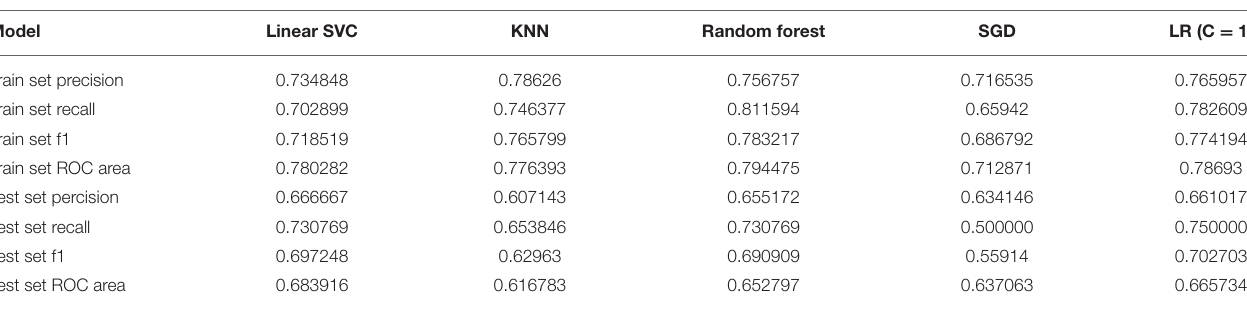
TABLE 3 | Performance comparison of machine learning